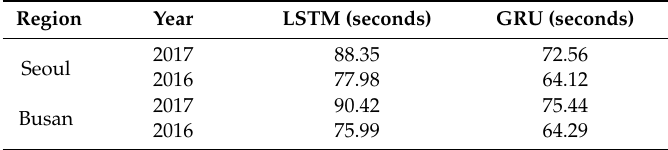
Table 5. Performance of LSTM vs. GRU daily data.